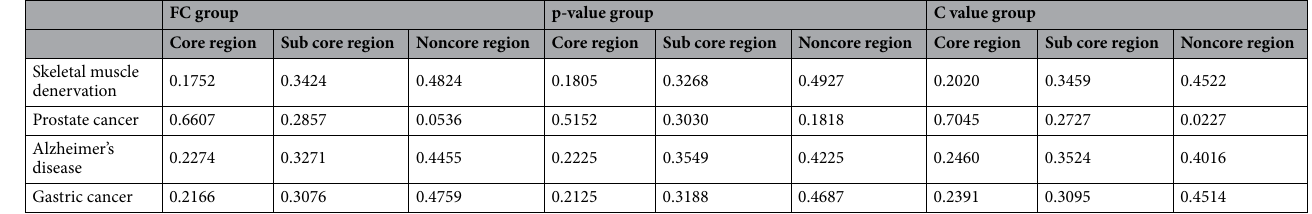
FC group p-value group C value